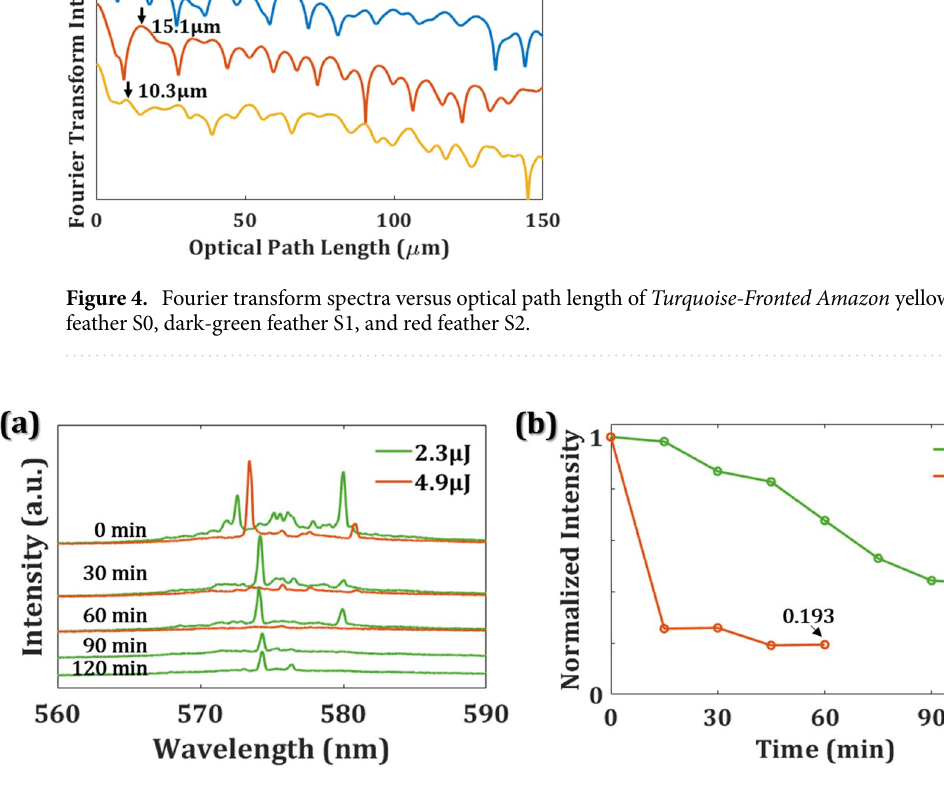
Figure 5. ( a ) Emission spectra of S0 with 2.3 μJ (green) and 4.9 μJ (red) pump energy for different exposure times. ( b ) the variation of normalized intensity from PL of S0 as a function of exposure